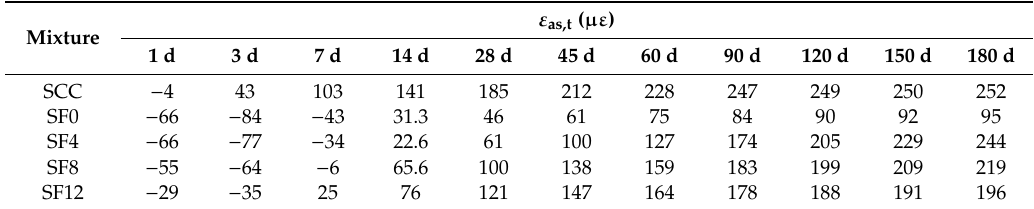
Table 6. Autogenous shrinkage of SCC and self-compacting